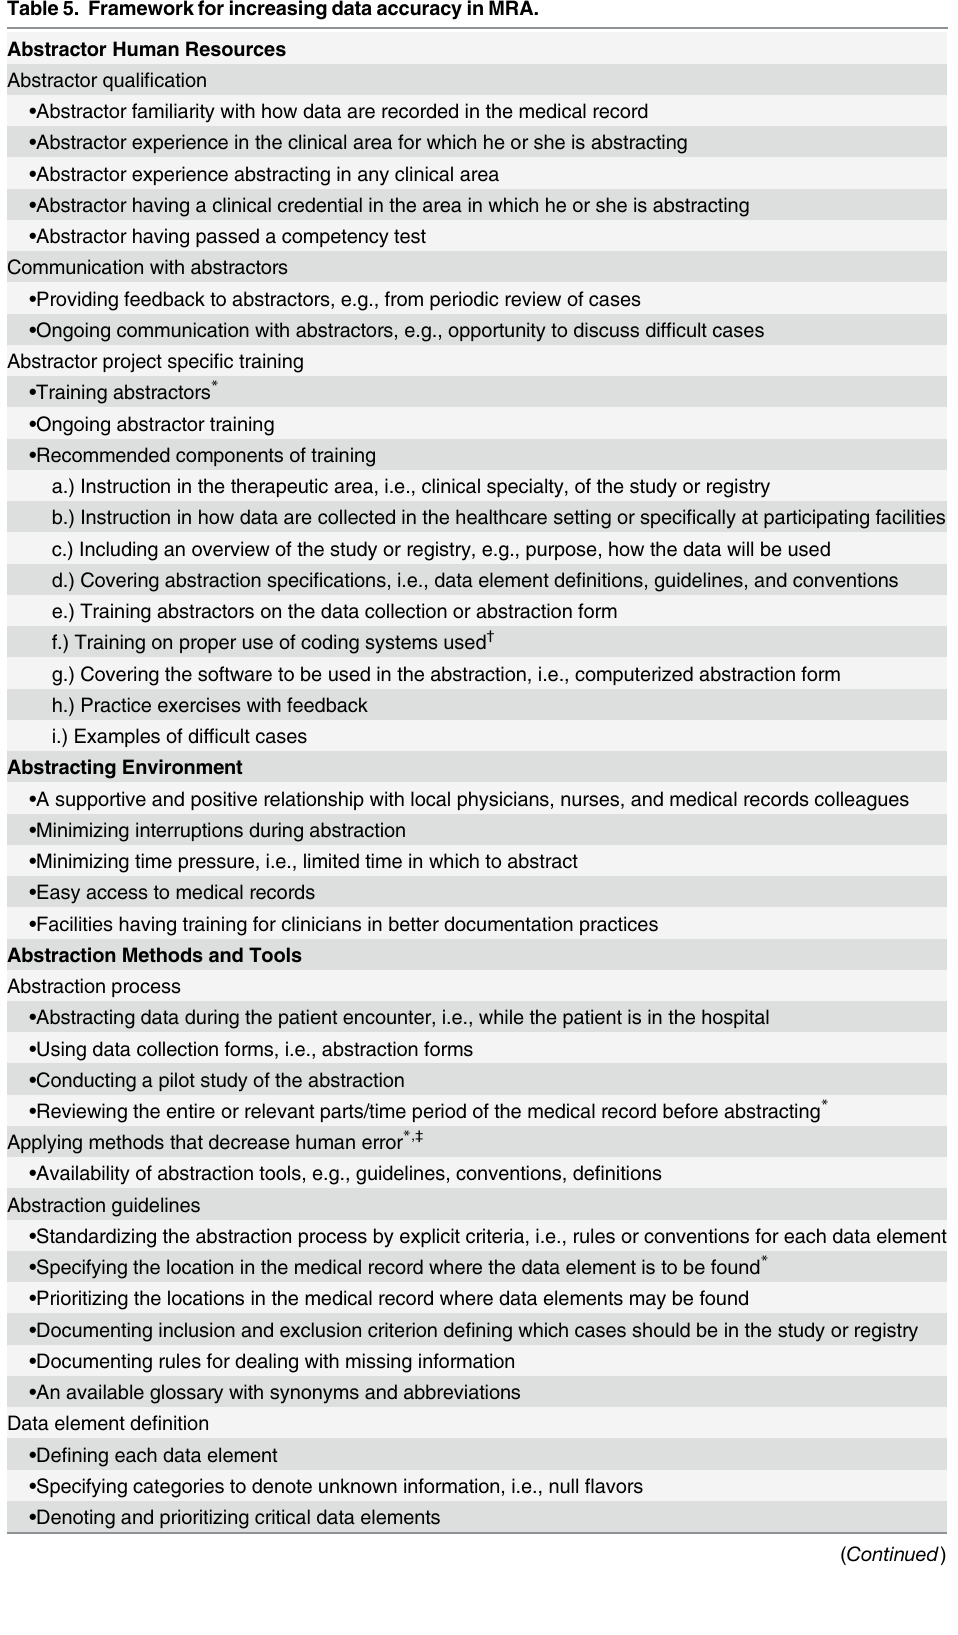
Table 5. Framework for increasing data accuracy in